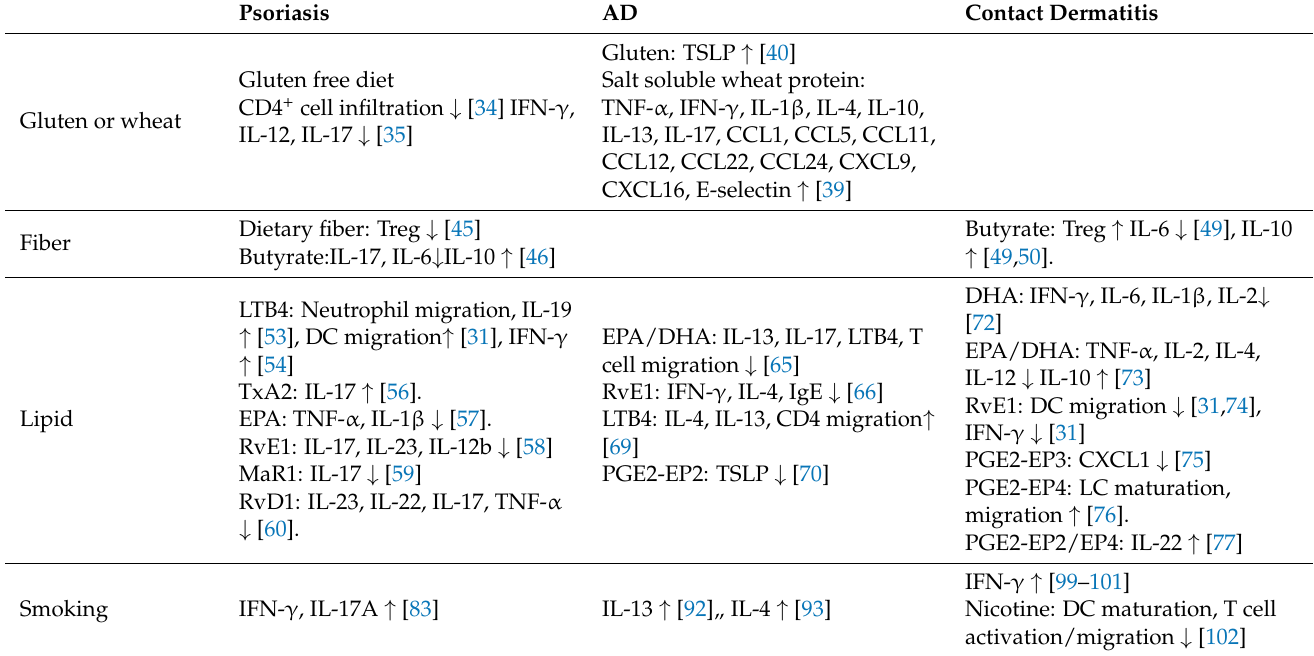
Table 1. Summary of inflammatory reaction in each skin inflammation disease